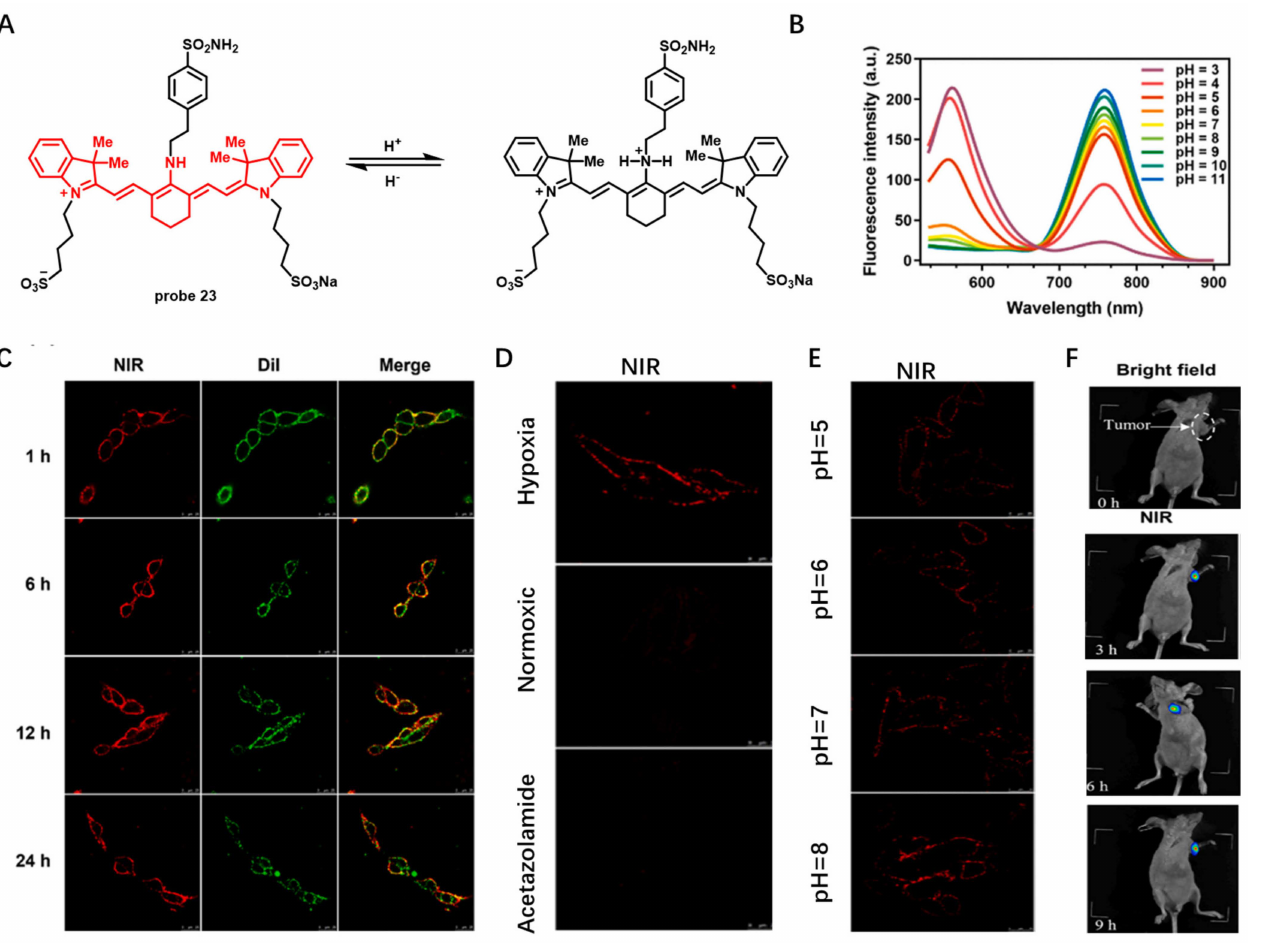
Figure 23. ( A ) Chemical structure of probe 23 and its response to pH. ( B ) Fluorescence emission spectra of probe 23 at different pH values. ( C – E ) Long-term CM imaging under different conditions. Scale bar: 25 µ m. ( F ) The NIR imaging of tumor mice using probe 23 . Copyright 2023 Elsevier